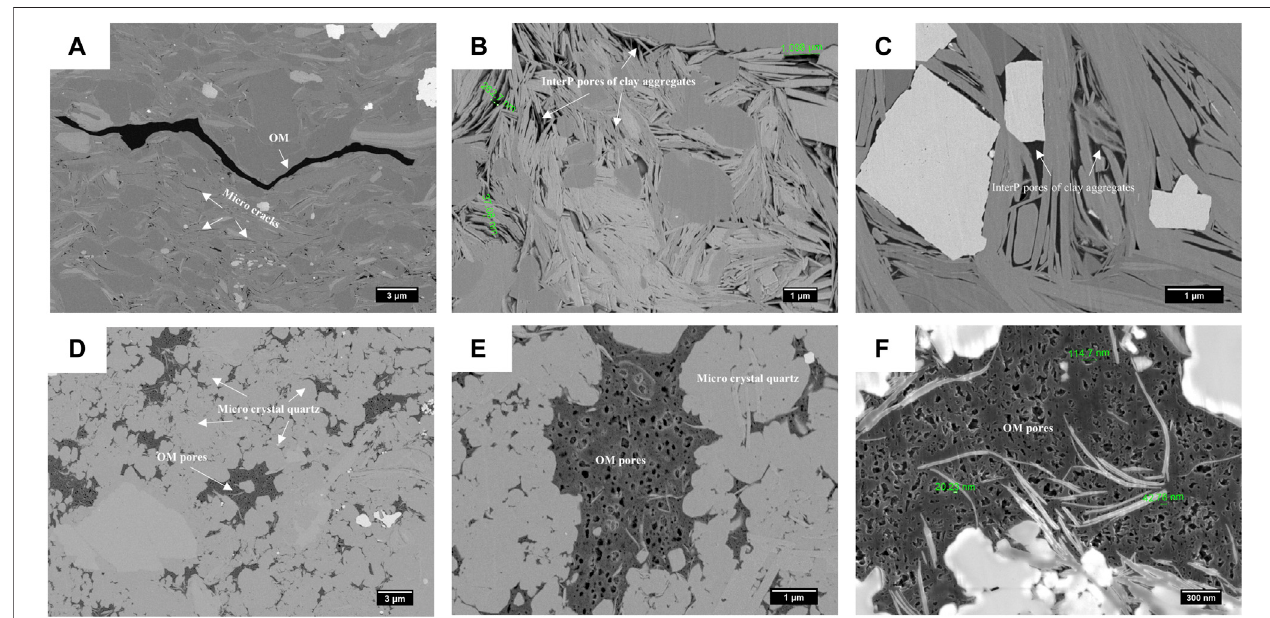
FIGURE 4 | SEM images of shale samples before WM injection. (A – C) Sample Sw-1, argillaceous mudstone, consisting mainly of fl aky pores in the clay minerals. (D – F) Sample JY9, siliceous mudstone with well-developed organic pores.